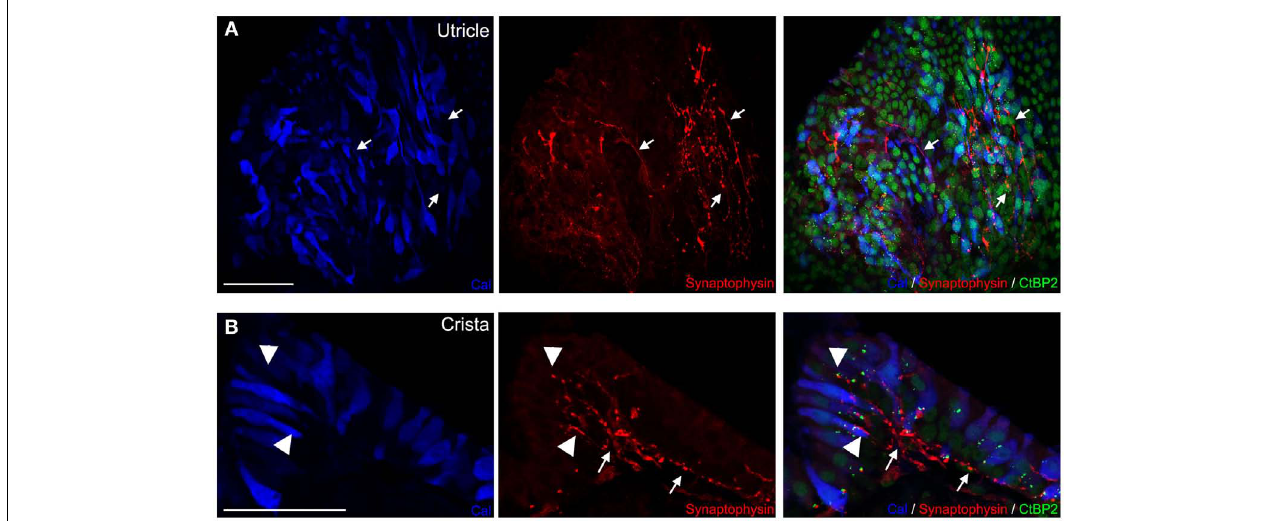
labeled small synaptic vesicles (red) contained in maturing synaptic afferents. Terminals of innervating fibers (arrows) entering sensory epithelia were observed. Co-labeling with ribeye shows close apposition of these synaptic terminals with ribbons in hair cells (arrow heads) in both cristae (A) and utricles (B) . Scale bars 50 μ